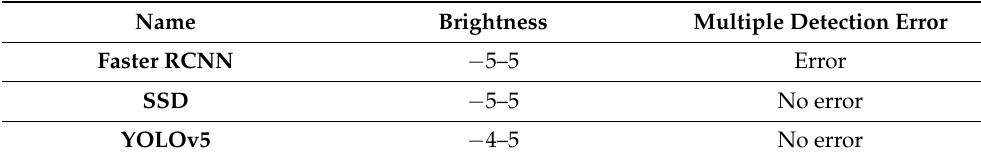
Table 1. Testing results for deep learning models ’ brightness.